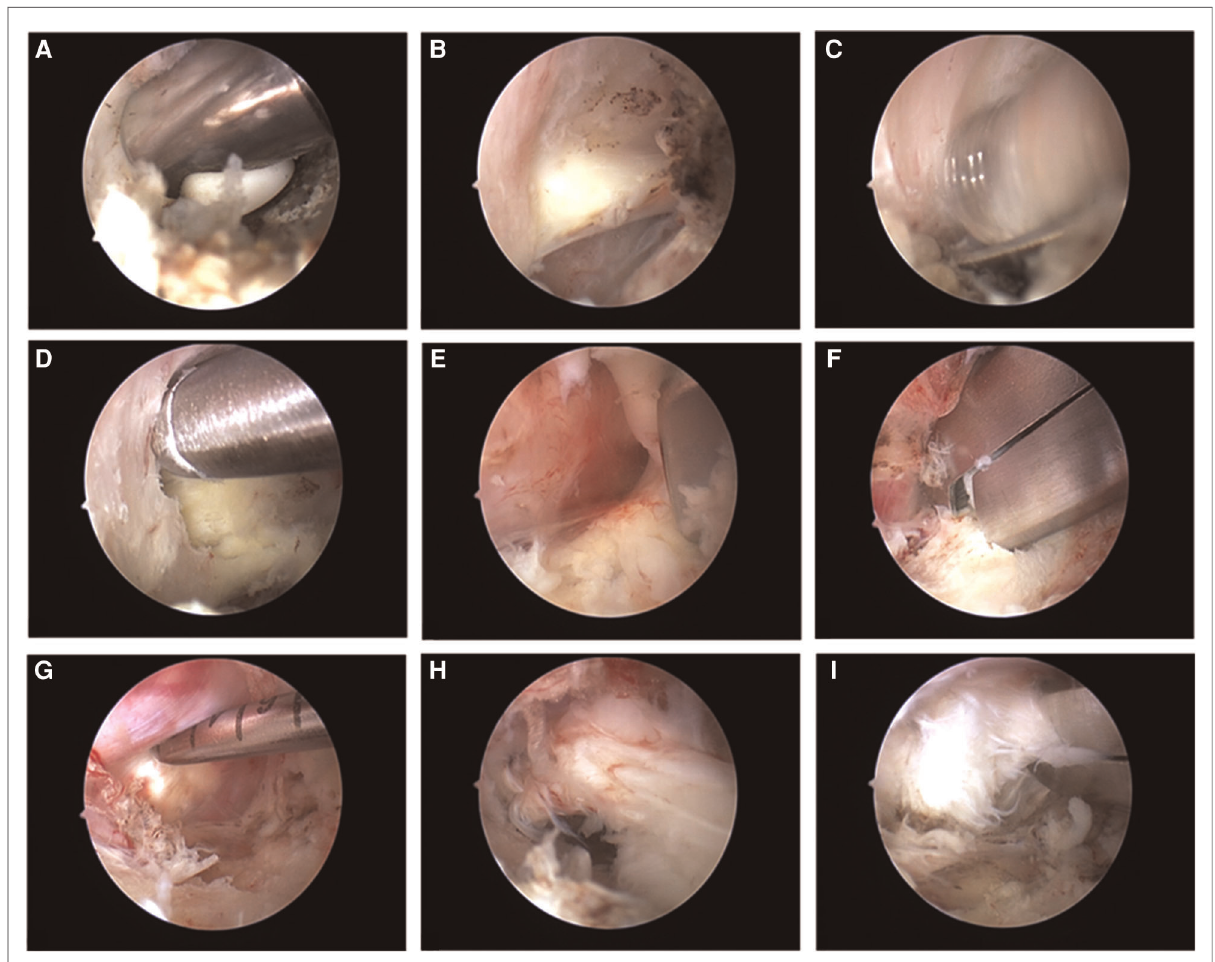
FIGURE 1 Intraoperative processes. ( A ) The radiofrequency probe is used to clean the remaining soft tissues or muscles over the lamina and ligamentum fl avum; ( B ) The ligamentum fl avum of the target interlaminar space and inferior edge of superior lamina are completely exposed; ( C ) The arthroscopic burr is used to thin out ispilateral lamina; ( D ) Kerrison punch is used to complete a hemilaminotomy until the upper edge of deep part of ligamentum fl avum is free; ( E ) The ligament is peeled down in caucal direction and is removed using the Kerrison punch; ( F ) Kerrison punch is used to undercut the facet down to the medial wall of the pedicle; ( G ) The adhesion between the nucleus pulposus and the surrounding soft tissue is separated by a probe; ( H ) The herniated nucleus pulposus is removed by using forceps; ( I ) Kerrison punch and forceps are used to remove the separated bony fragment of vertebral